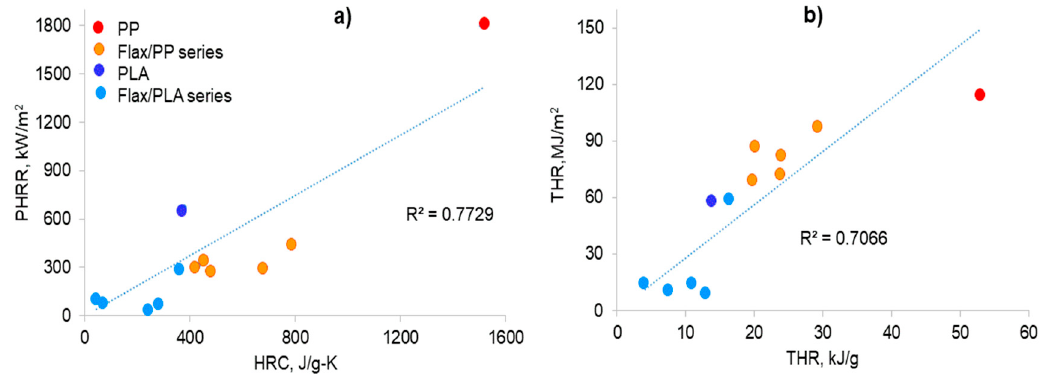
Figure 2. Correlation between PCFC and cone calorimetric results: ( a ) HRC from PCFC versus PHRR from cone calorimetry and ( b ) THR from PCFC versus THR from cone calorimetry for PP, PLA, and composites (both unmodified and fire retarded). Table 3. Percentage change in flammability parameters w.r.t those of the respective control